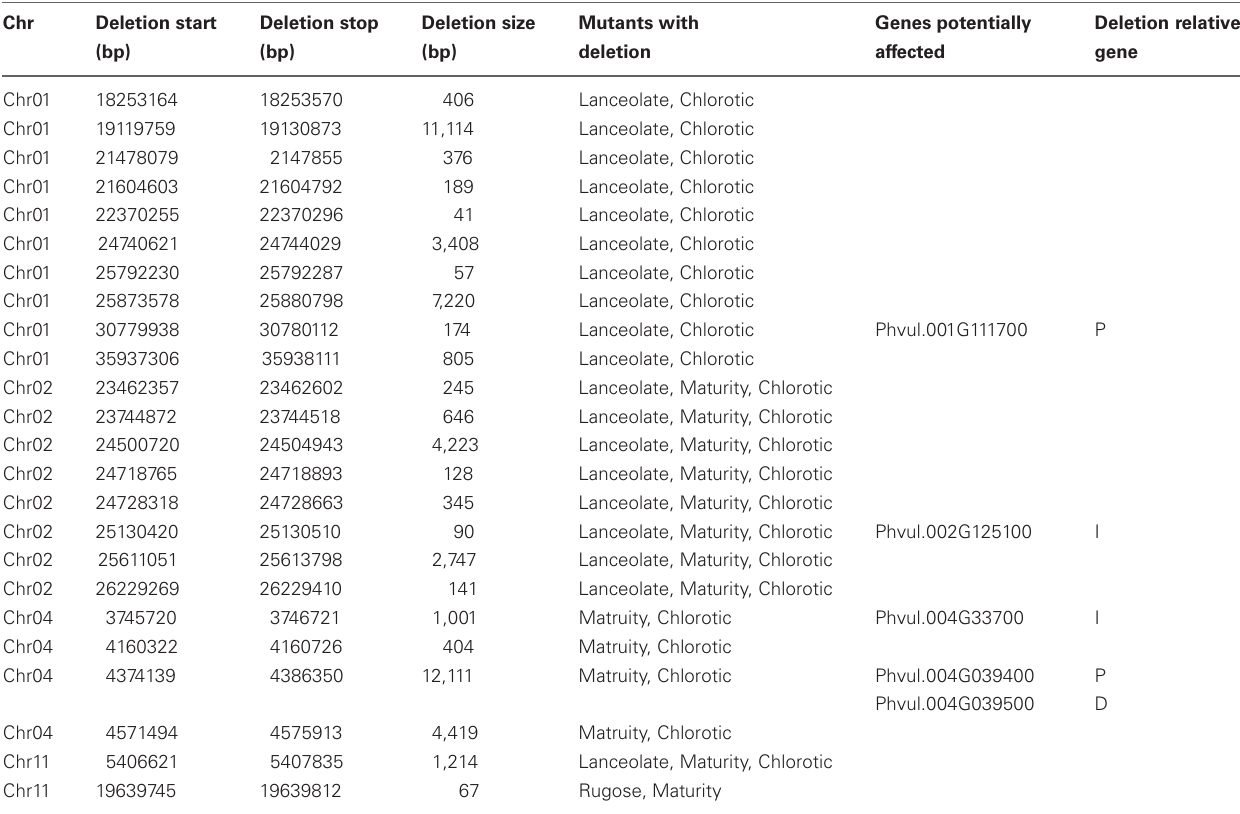
Genomic deletions identified by the program CREST that belong to SV Class 2. All SV were visually verified using IGV. This class of SV represents regions of heterogeneity within Red